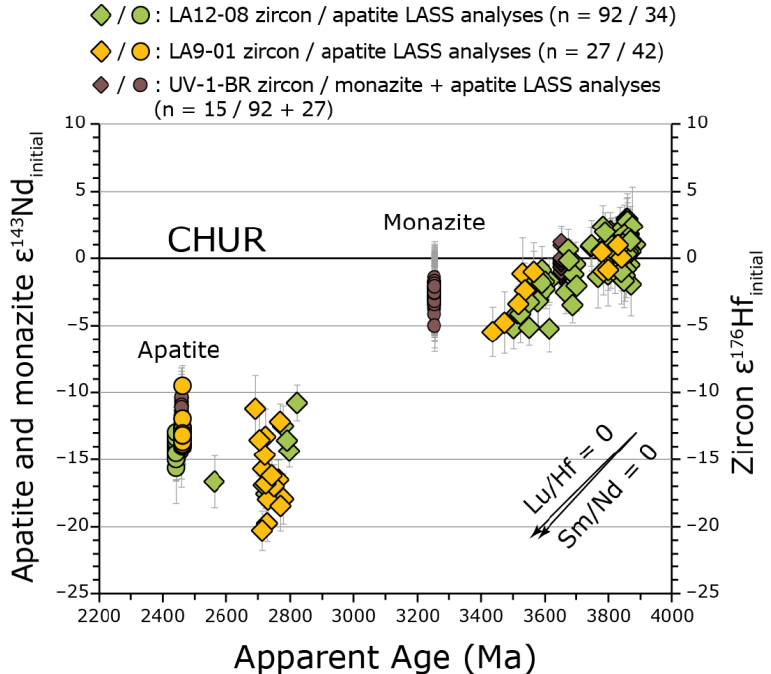
Figure 6. Epsilon (ε) 143 Nd and 176 Hf versus apparent age (Ma) relations for zircon and apatite from the same rock compared with monazite and apatite from a nearby rock. Diamond symbols are zircon analyses, circles are either apatite (for samples LA12-08, LA9-01 and UV-1-BR) or monazite analyses (UV-1-BR only). Zircon apparent ages are 207 Pb/ 206 Pb apparent ages for LA12-08 and LA9-01 and upper intercept Discordia age for UV-1-BR. Apatite and monazite apparent ages are those calculated from the Sm–Nd isochron array (Figure 3). Uncertainty bars are reported at 95% confidence level. Zircon LASS analyses for LA12-08 and LA9-01 are from [5,47]. UV-1-BR LASS analyses are from [28].